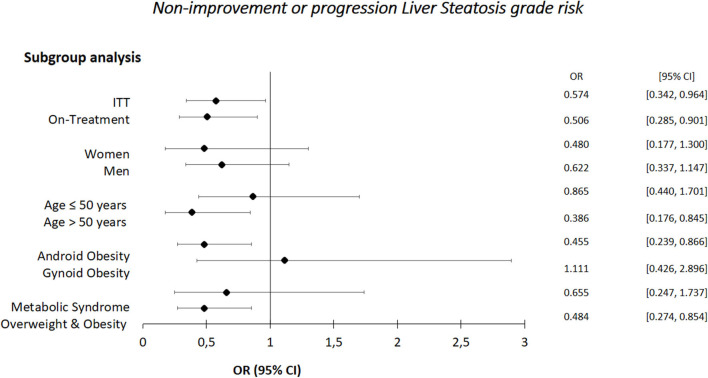
Non-improvement or progression liver steatosis risk.